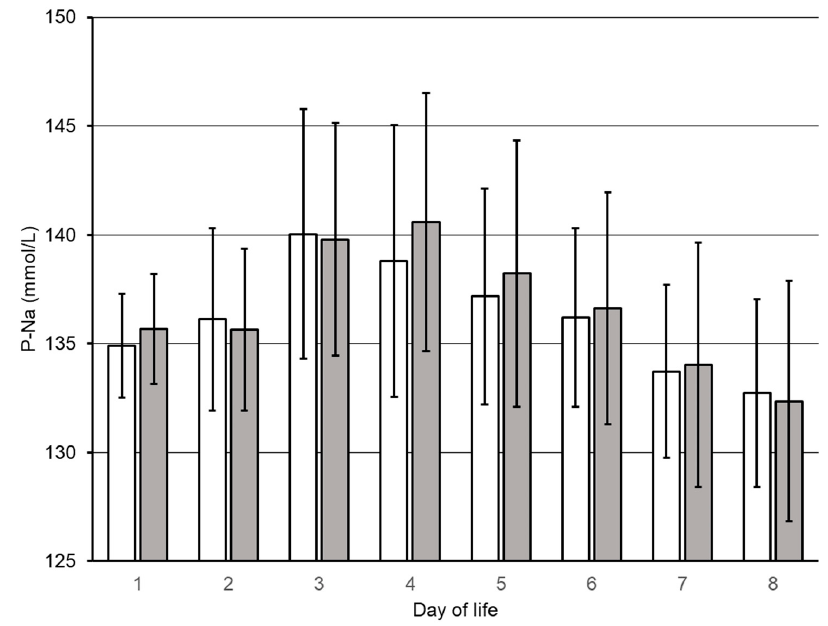
Figure 2. Trajectories of first week plasma sodium (P-Na) concentrations. RESTRICTED group, open bars; LIBERAL group, filled bars; Mean ± SD.